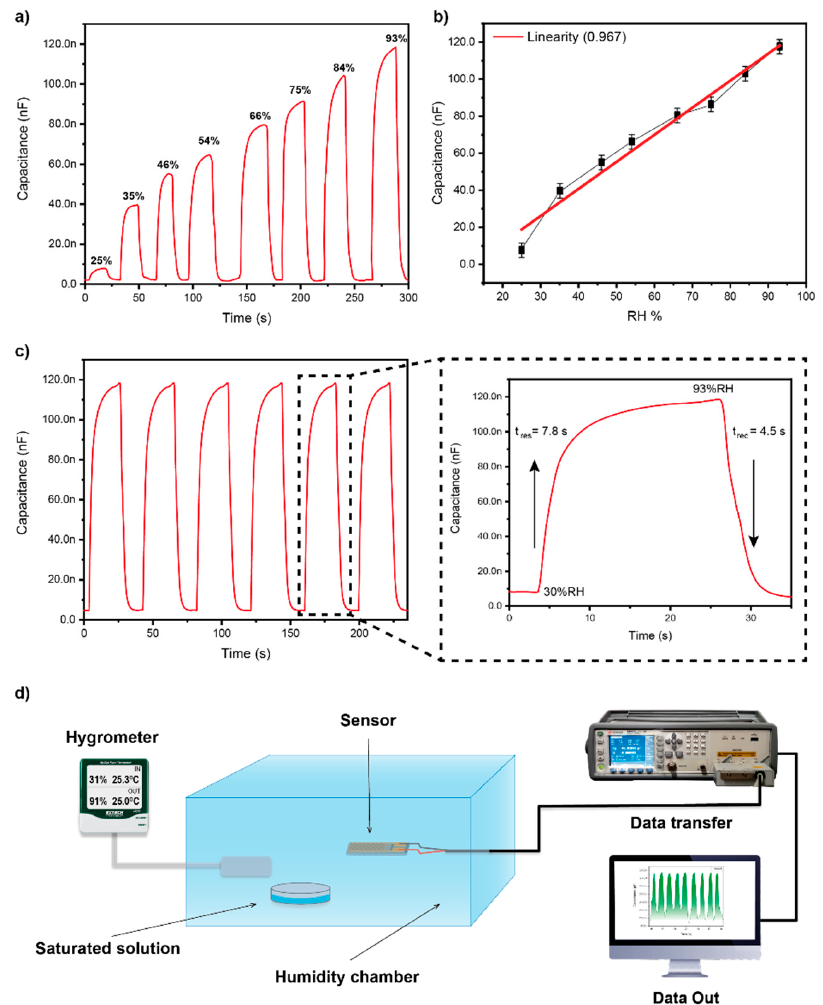
Figure 3. Humidity measurements. ( a ) Sensitivity, ( b ) linearity, ( c ) response and recovery times, and ( d ) measurement setup of response and recovery times.